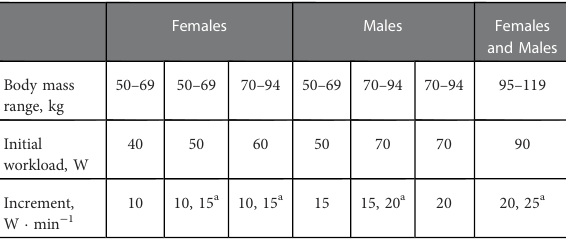
TABLE 1 Stationary cycling protocols of the P10-study for CPET. Females